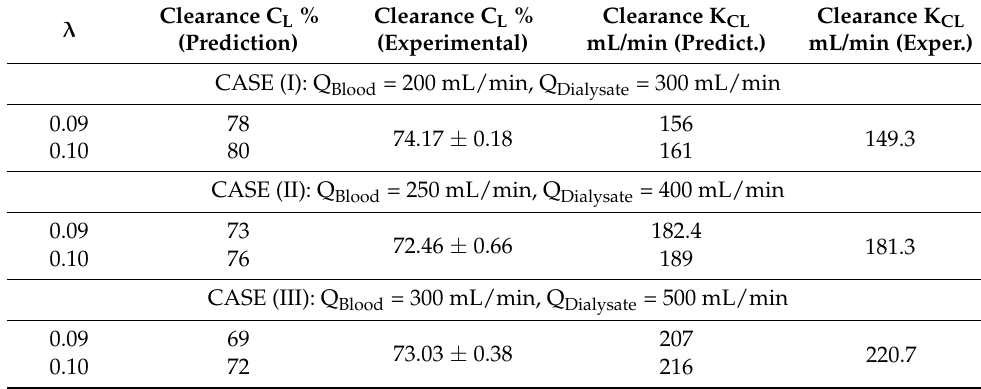
Table 3. Comparison of predicted and experimentally determined urea